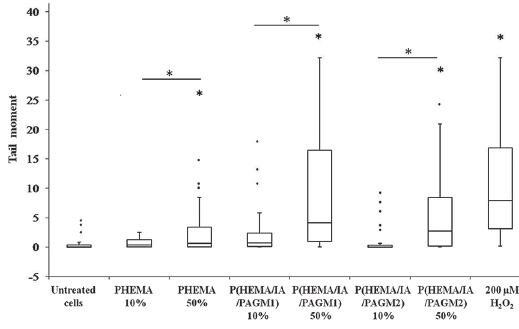
Figure 3: Tukey box plot diagram for tail moment parameter of HeLa cells treated with 10% and 50% extracts of HEMA-based hydrogels, 200 μM H O as positive control and untreated cells. 2 2 O (b) and cells Whiskers extend to the 1.5 box heights. If minimum and 2 2